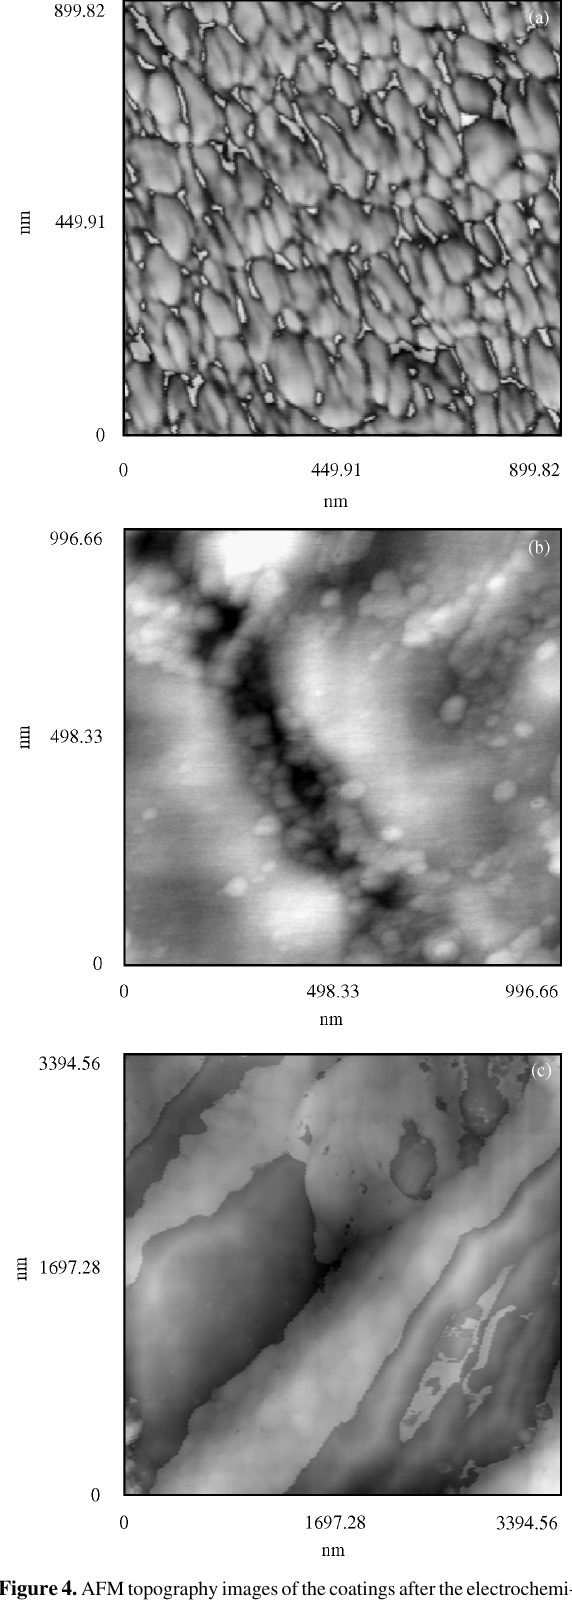
Figure 4. AFM topography images of the coatings after the electrochemi- cal